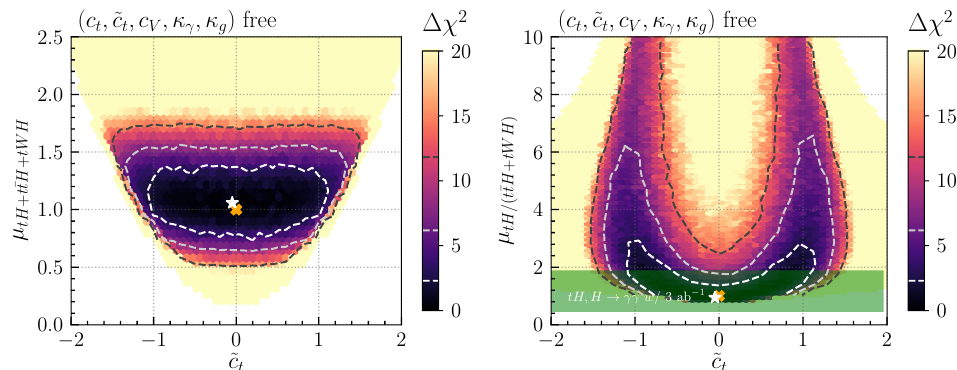
Figure 1: Left: Signal strength for combined top-associated Higgs production for the five-dimensional global fit in dependence of ˜ c . The color encodes the profiled ∆ χ 2 t distribution of the fit. The white, light-gray, and dark-gray contour lines represent the 1 σ , 2 σ , 3 σ confidence regions, respectively. Right: Same as left plot but the signal strength for tH Higgs production divided by the signal strength for t ¯ tH and tW H production is shown. The green band indicates the impact of the projected tH measurement with 3ab − 1 at the